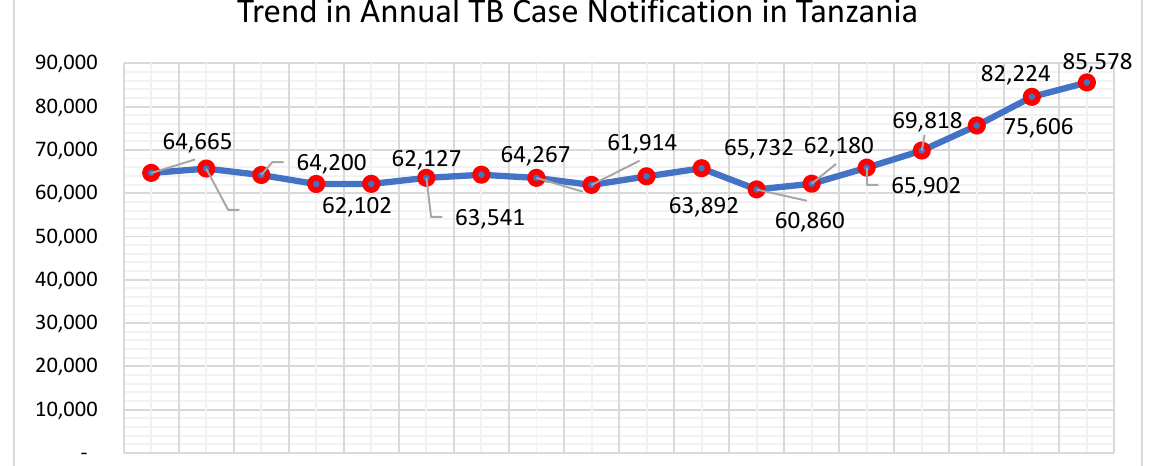
Figure 1. Trends in quarterly tuberculosis case notification in the quality improvement initiative implementation vs. control facilities, Dodoma Region, Tanzania, 2015–2017. QI = quality improvement model.